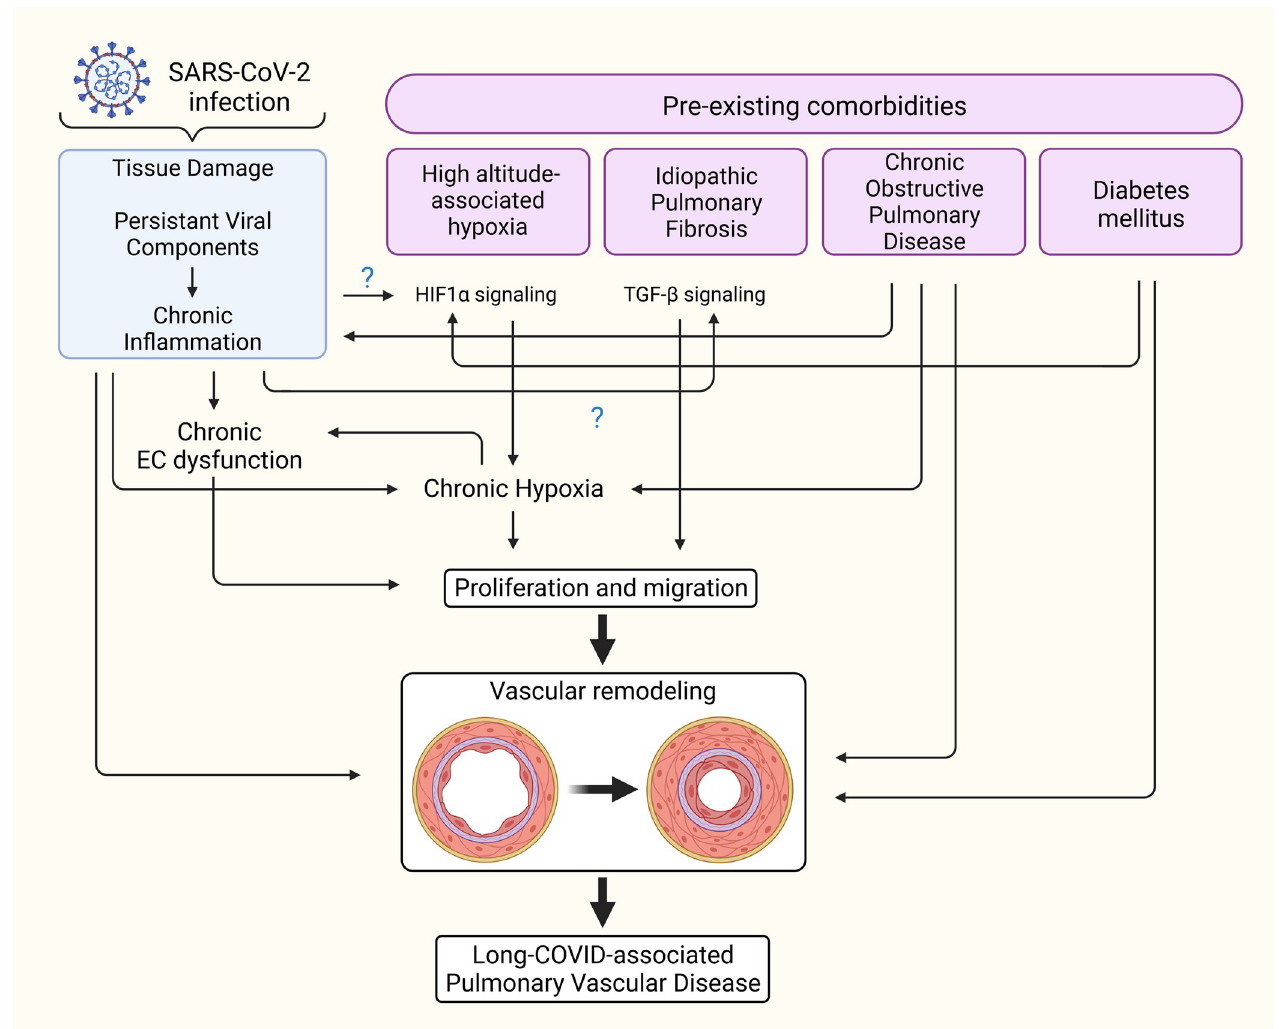
Fig 2. Comorbidities that may synergize with COVID-19 to predispose risks to PH. The possible interactions between long COVID state and preexisting comorbidities that may contribute to pulmonary vascular remodeling and the development of PH. Created with BioRender.com. COVID-19, Coronavirus Disease 2019; HIF1- α , hypoxia-inducible factor 1-alpha; PH, pulmonary hypertension; SARS-CoV-2, Severe Acute Respiratory Syndrome Coronavirus 2; TGF- β , transforming growth